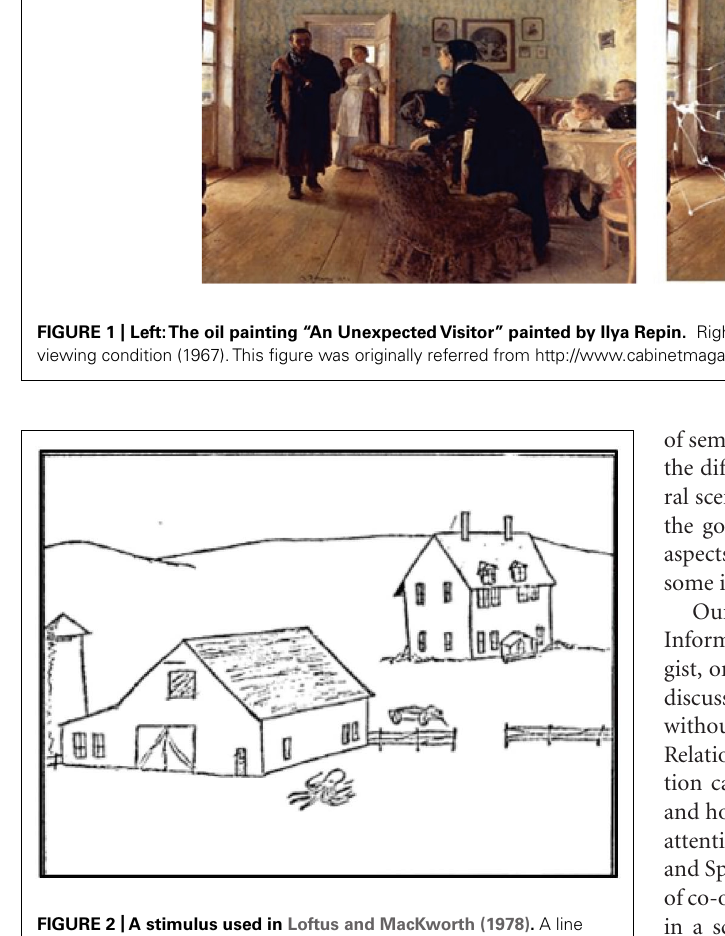
FIGURE 2 |A stimulus used in Loftus and MacKworth (1978). A line drawing of an octopus was placed on a line-drawn farmyard. Figure reproduced from Loftus and MacKworth